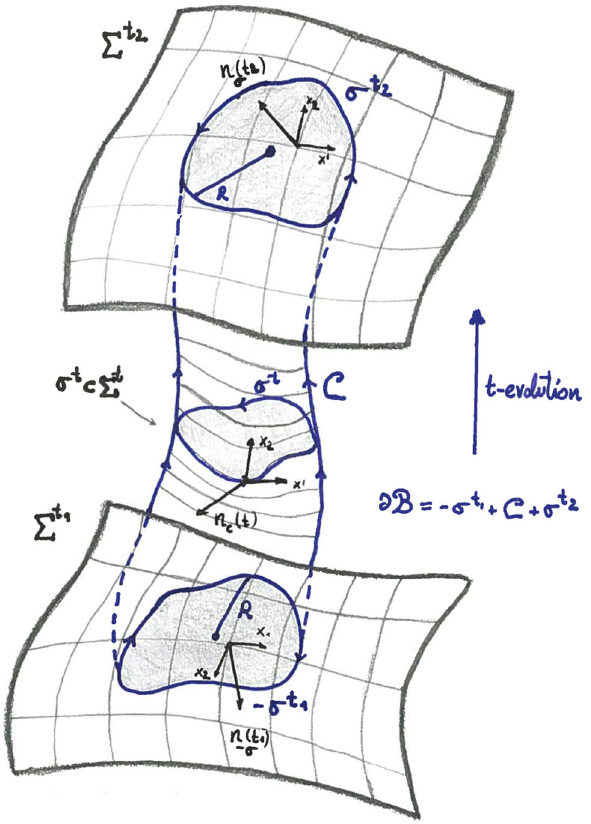
Fig. 1 Illustrationofthedifferentpartsof B and ∂ B .Theblackoriented vector basis define the orientation of ∂ B